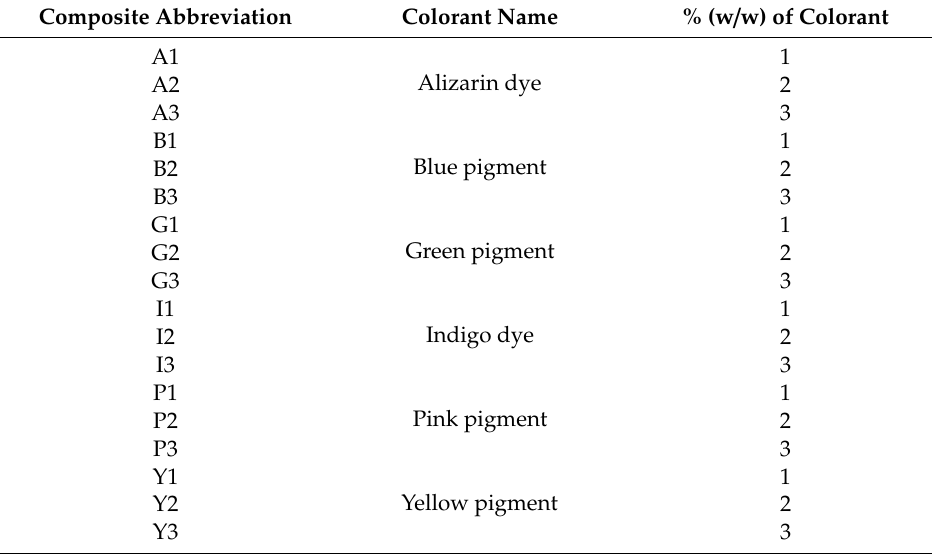
Table 2. List of the 18 composites produced for this study. The composite names were based on the initial letter of each additive and the weight percentage of the